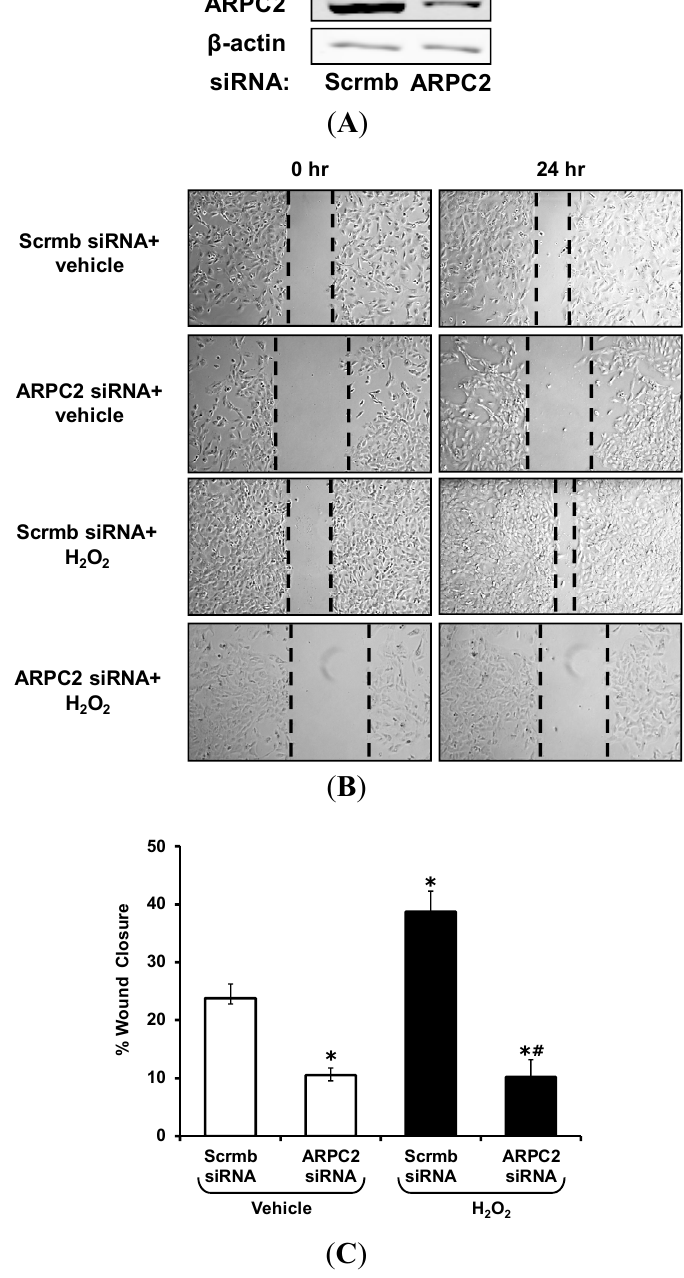
Figure 6. H O stimulates VSMC migration via ARPC2. ARPC2 and Scrmb 2 2 O (50 µM) for 24 h. Cell siRNA-transfected VSMC were incubated with vehicle or H 2 2 migration was determined by wounding of VSMC monolayers. Images were captured at 0 and 24 h. ( A ) Representative Western blot showing ARPC2 and β -actin expression in Scrmb- and ARPC2-siRNA-treated VSMC. Images are representative of three independent experiments with similar results; ( B ) Representative images of wound healing at 0 and 24 h after scratch are shown (original magnification, ×5). Dashed lines denote the approximate edge of the wound at 0 and 24 h time points; ( C ) Quantitative assessment of VSMC migration ( n = 6). Data represent the mean ± SEM. * p < 0.05 vs . Scrmb siRNA + vehicle treatment; # p < 0.05 vs . Scrmb siRNA + H O treatment. 2 2 ARPC2ScrmbARPC2 β -actin siRNA: ( A ) 0